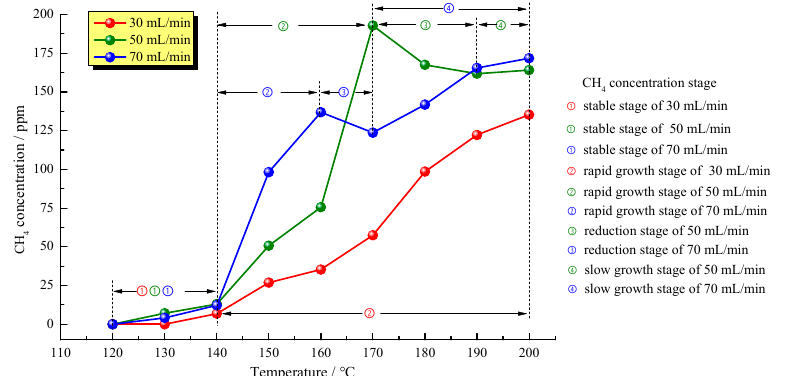
Figure 4. Relationship between the CH 4 concentration and the temperature at different air supply rates.